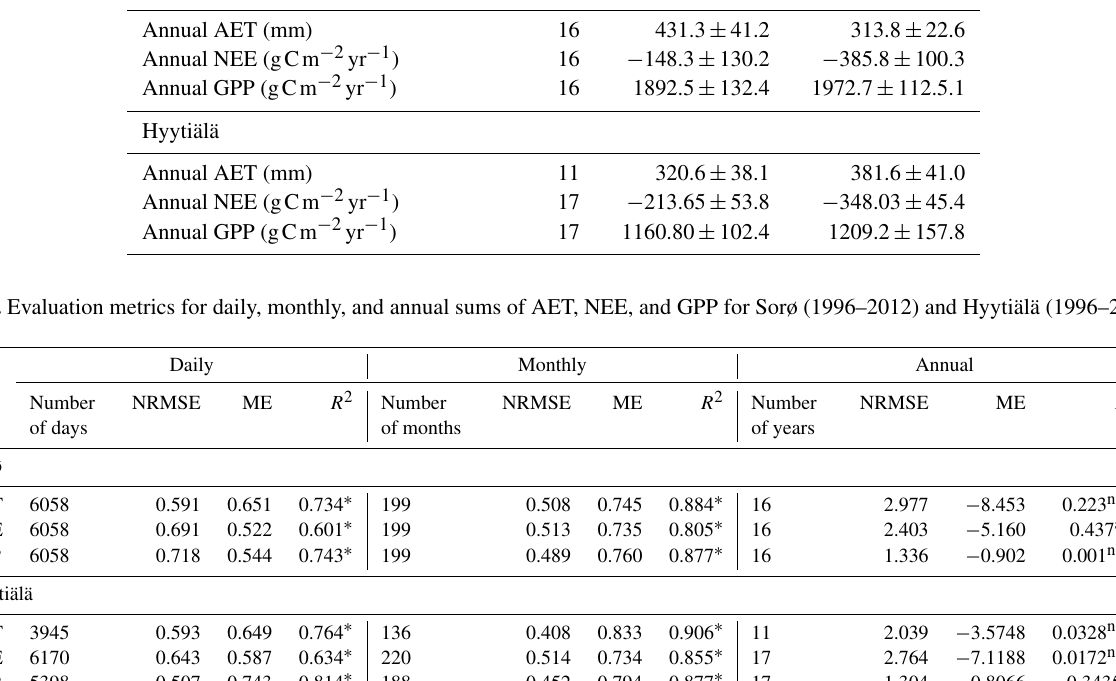
Table 4. Annual long-term means ( ± SD) of water and carbon fluxes in Sorø (1997–2012) and Hyytiälä (1996–2014). Number of years Observed average